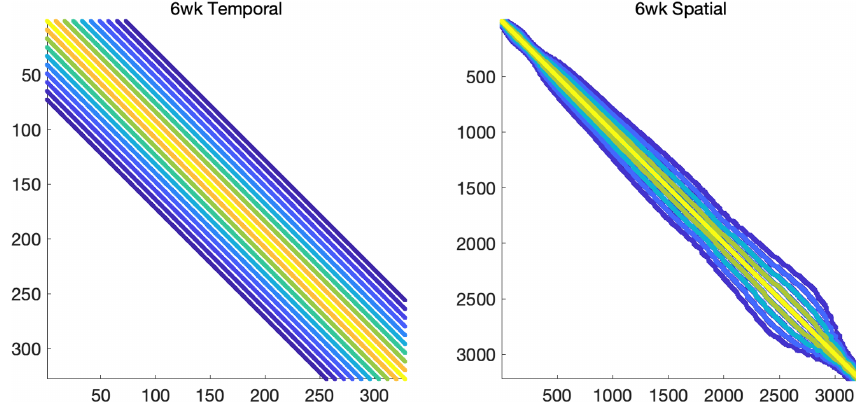
Figure 2. Sparsity pattern of the prior covariance matrices Q t and Q g for the 6-week case